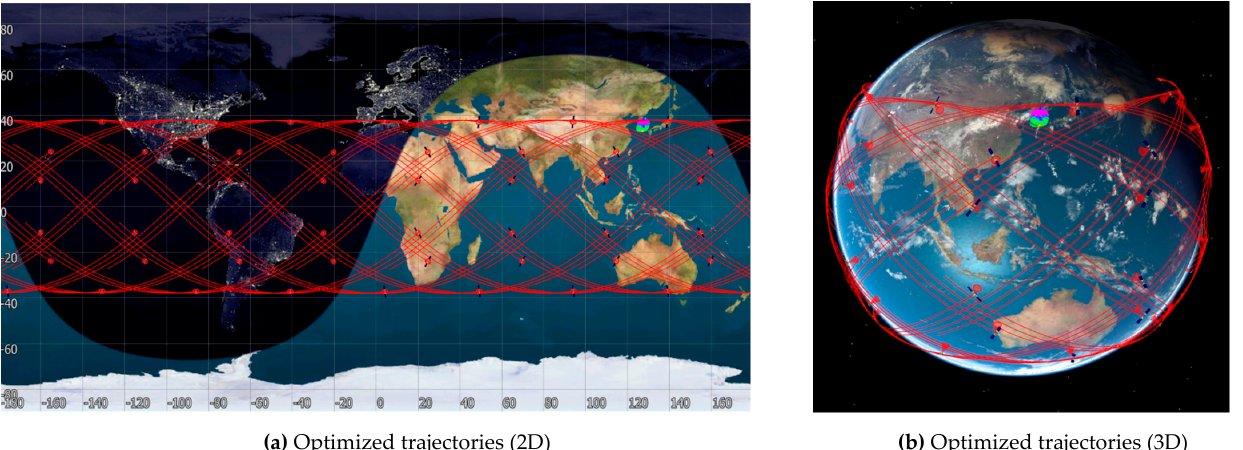
Figure 20. Optimized orbital trajectories in a small satellite constellation (defined—area of interest).